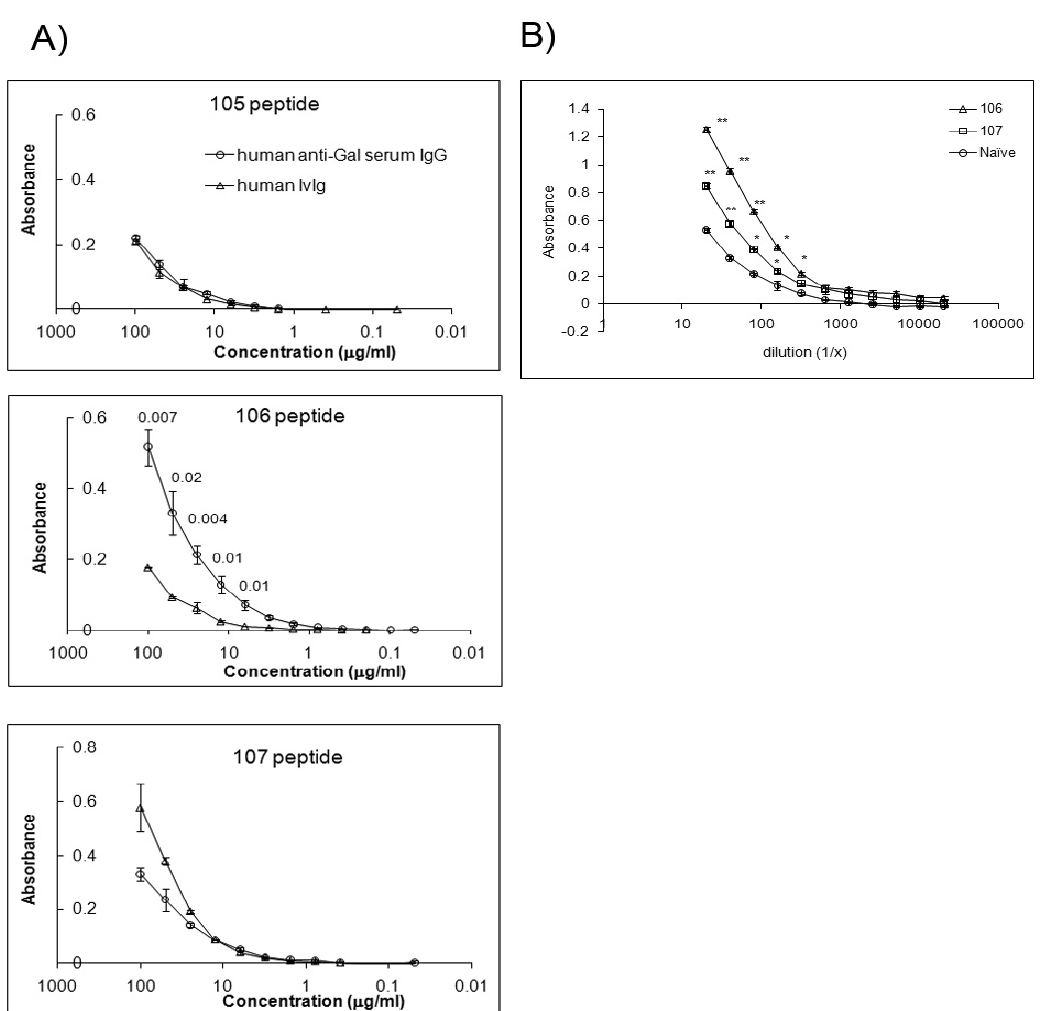
Figure 3. Anti-terminal Gal antibodies cross-react with CMPs and reactivity is increased after CMP immunization. Human anti-Gal antibodies bind to CMP 106 and CMP 107 and immunization with both CMPs induced IgM antibodies reactive with terminal alpha